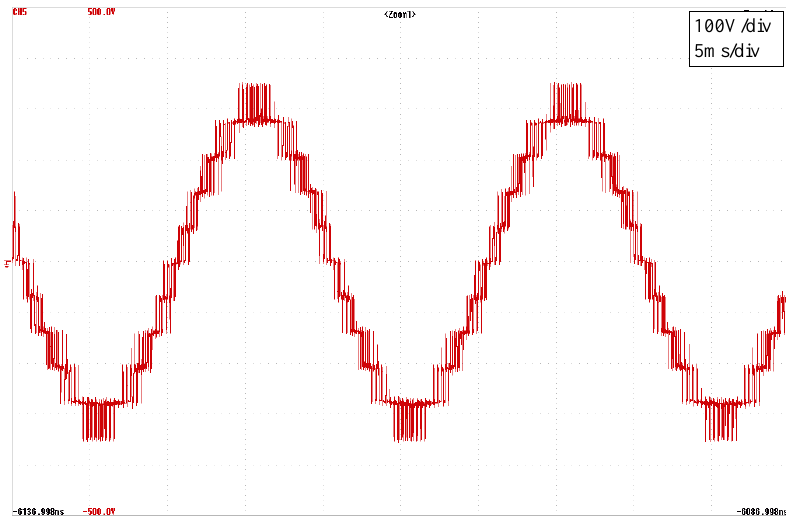
Figure 22. PS-SPWM line-to-line output waveform without load.